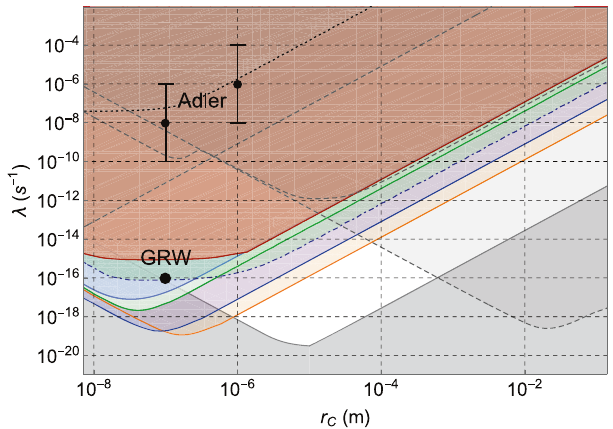
Fig. 7 Exclusion plots for the Continuous Spontaneous Localization (CSL) model parameters { r c , λ CSL } from interferometric experiments. Black dots, with their error bars, represent the GRW ’ s 43 and Adler ’ s 44,128 theoretical values for these parameters. The solid lines, and their respective excluded areas, show the upper bound that can be obtained by near fi eld interferometric experiments in space with the parameters used in our simulations. In particular, the red line is obtained with mass m = 10 7 amu, free evolutions times before and after the laser grating t 1 = t 2 = 12s and the ratio between the laser ’ s energy and spot area E L / a L = 1.1×10 − 2 J/m 2 . The dark-green one with m = 10 8 amu, t 1 = t 2 = 10 s and E L / a L = 3.5×10 − 4 J/m 2 . The green, solid line with m = 10 9 amu, t 1 = t 2 = 10s and E L / a L = 8.7×10 − 6 J/m 2 . The blue one with m = 10 10 amu, t 1 = t 2 = 50 s and E L / a L = 8.7× 10 − 6 J/m 2 and, fi nally, the orange solid line with m = 10 11 amu, t 1 = t 2 = 50 s and E a = 2.2×10 − 5 J/m 2 . For comparison, the blue dot-dashed line shows the L / L upper bound that could be achieved with a ground-based interferometric experiment with m = 10 7 amu and times t 1 = t 2 = 9.95s — free-falling times which are clearly beyond current reach for ground-based experiments — as discussed in a recent study of four of the authors 26 . Finally, the dashed gray line represents the upper bounds given by current non-interferometric tests 41,53,70,72 , the black dotted lines on the top of the fi gure are the current upper bounds coming from interferometric tests 16,40,127,129 , and the gray area at the bottom of the plot represents the theoretical lower-bound 130